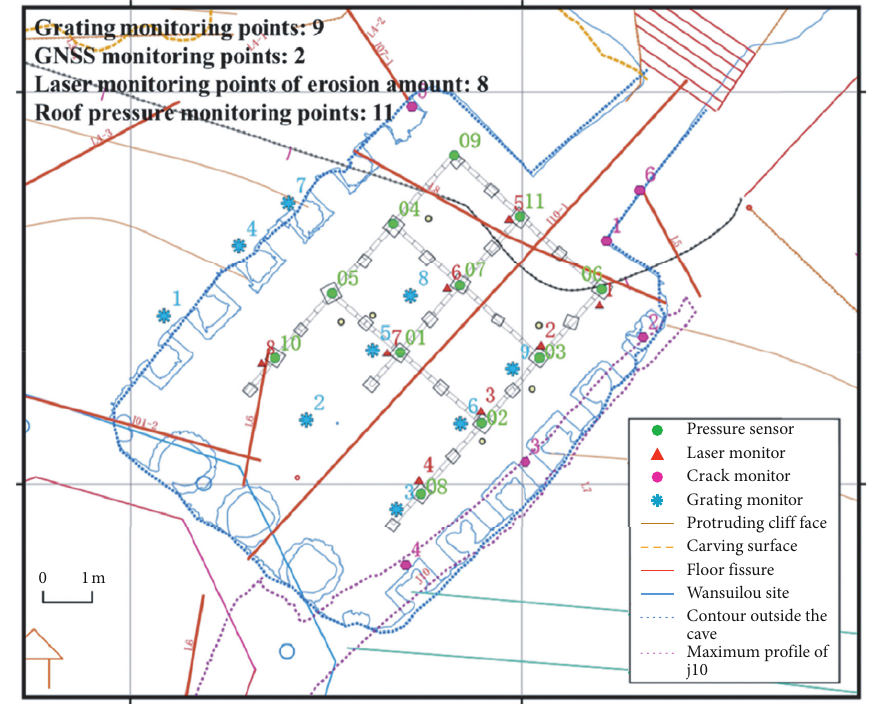
Figure 2: Layout of measuring points of Yuanjue rock cave within Dafowan.